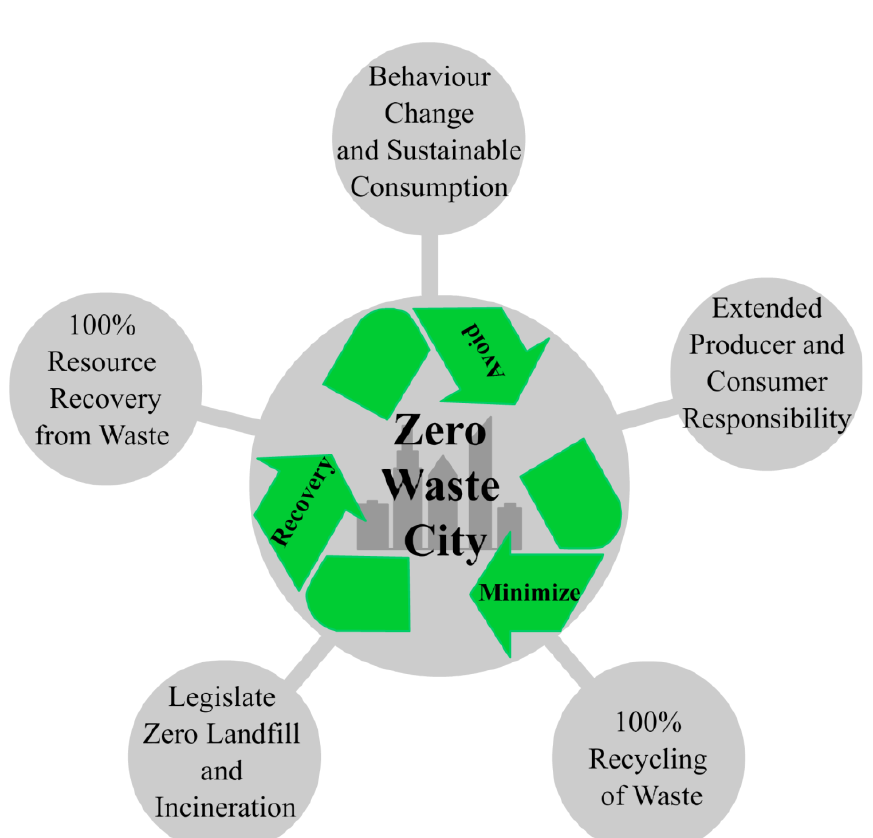
Figure 3. A holistic zero waste city model, with five inter-connected key principles that need to be applied